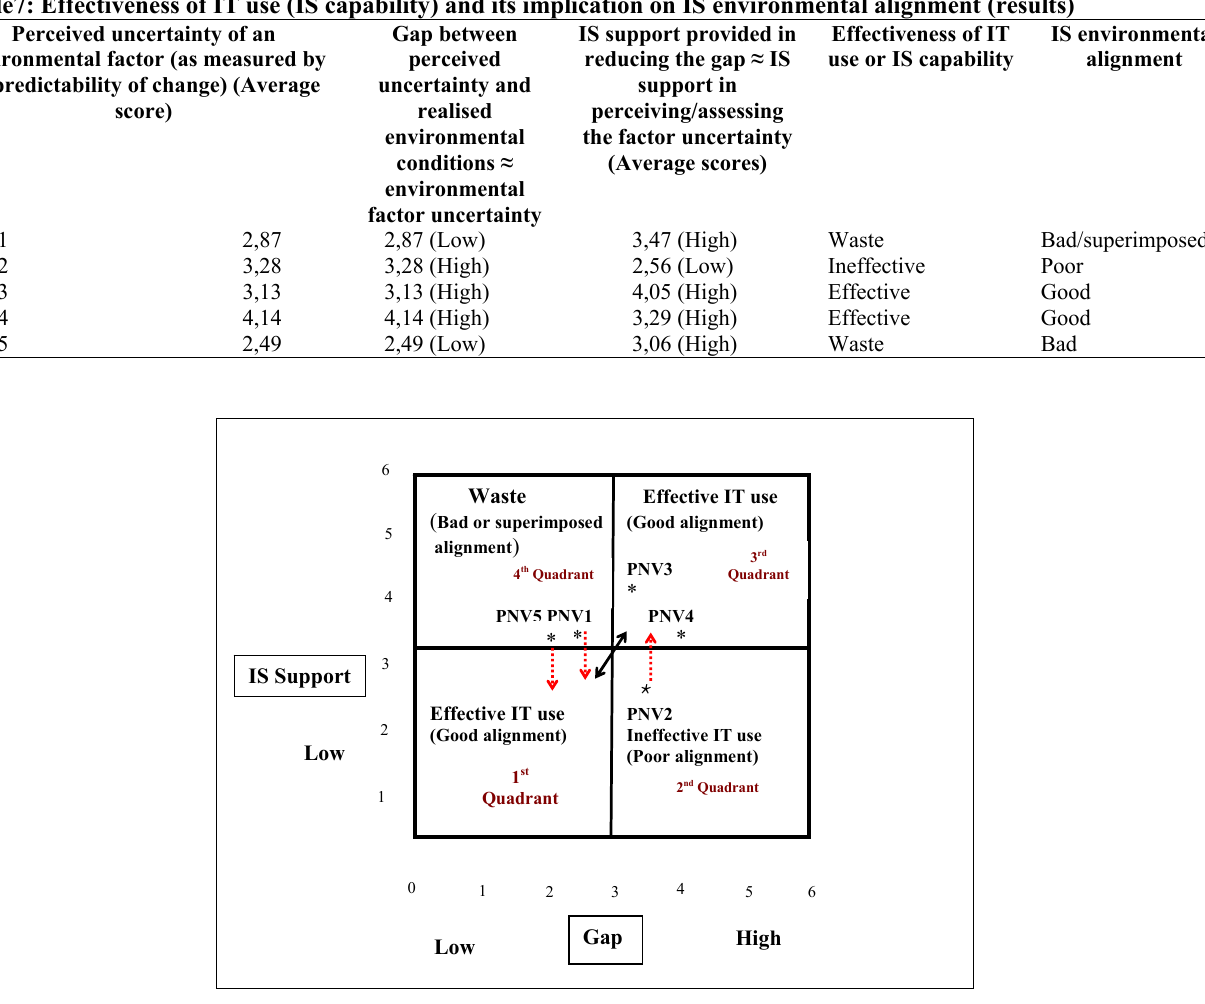
Table7: Effectiveness of IT use (IS capability) and its implication on IS environmental alignment (results) Perceived uncertainty of an environmental factor (as measured by unpredictability of change) (Average